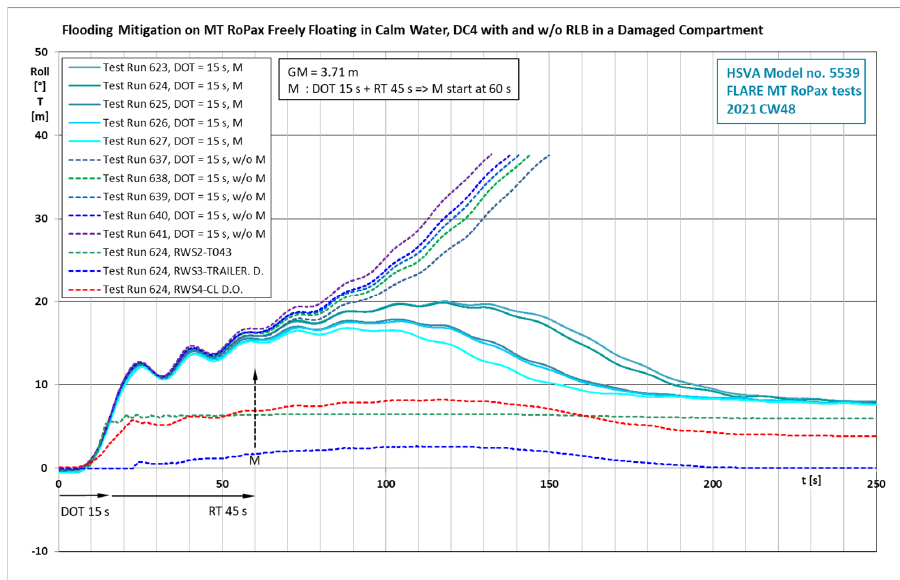
Figure 13. Damage Case 4 with damage opening time 15 s: Roll angle as a function of time with (solid lines) and without (dashed lines) recovery of lost buoyancy in the damaged compartment T045. The dashed curves below show the water height in the damaged compartments T043, on the trailer deck sensor, and just outside of the damage opening at its centerline for Test Run 624.